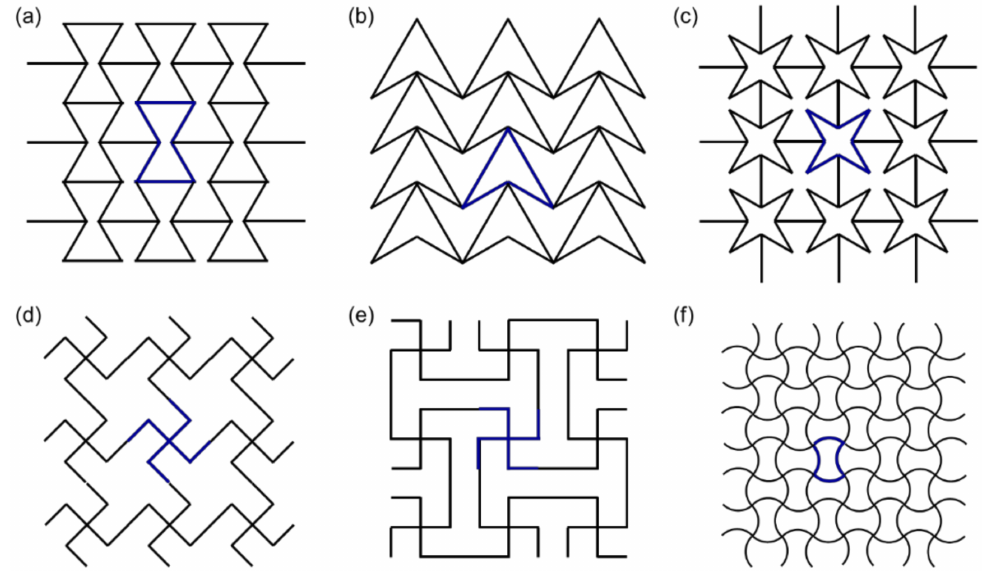
Figure 13. Re-entrant structures. ( a ) re-entrant honeycomb; ( b ) double arrowhead; ( c ) star honey- comb; ( d ) structurally hexagonal re-entrant honeycomb; ( e ) lozenge grids; ( f ) sinusoidal ligaments. Reprinted with permission from Ref. [104]. Copyright 2021,